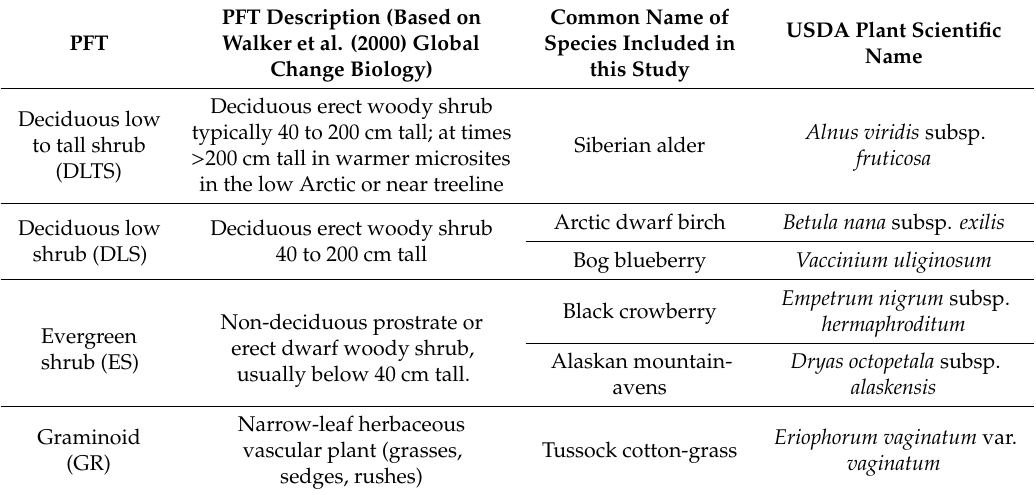
Table 2. Description of plant functional types (PFTs) used in this study and corresponding plant species. PFT descriptions are modified from Walker et al. (2000). Nomenclature for plant species names follows the PLANTS database (USDA NRCS